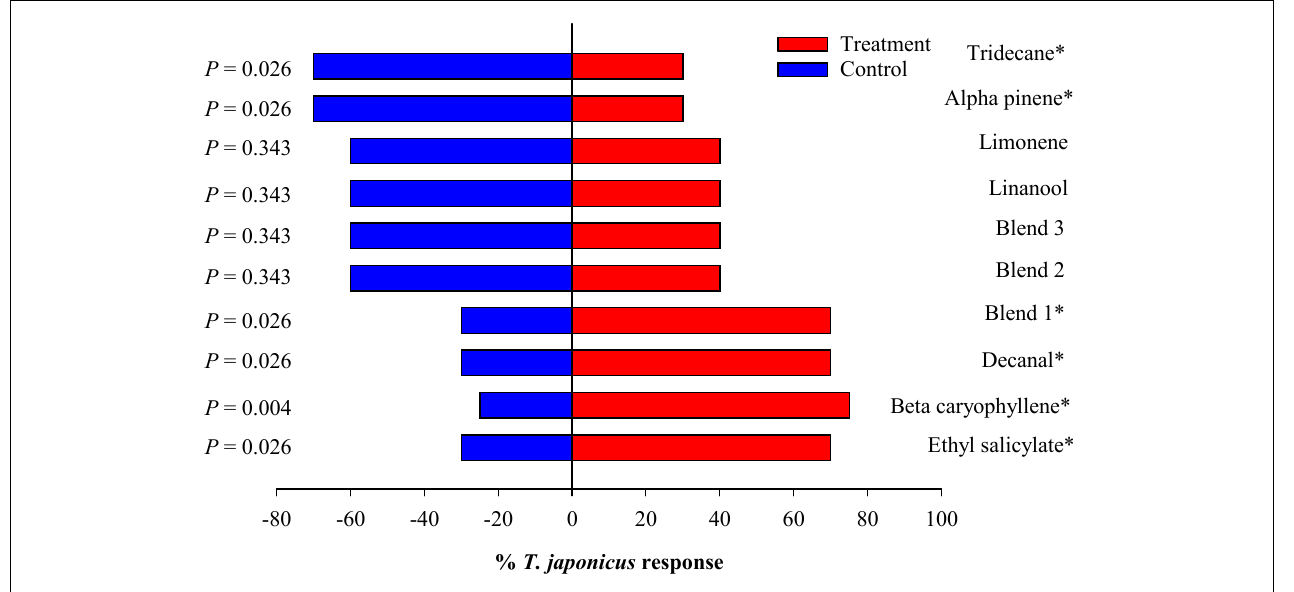
FIGURE 5 | Responses of Trissolcus japonicus to synthetic compounds in Y-tube. Blend 1 (ES, BC, and decanal), blend 2 (TR, BC, lim, and Lin), and blend 3 (ES, TR, BC, lim, and Lin). Asterisks indicate significant difference between the treatments at p = 0.05 using likelihood ratio